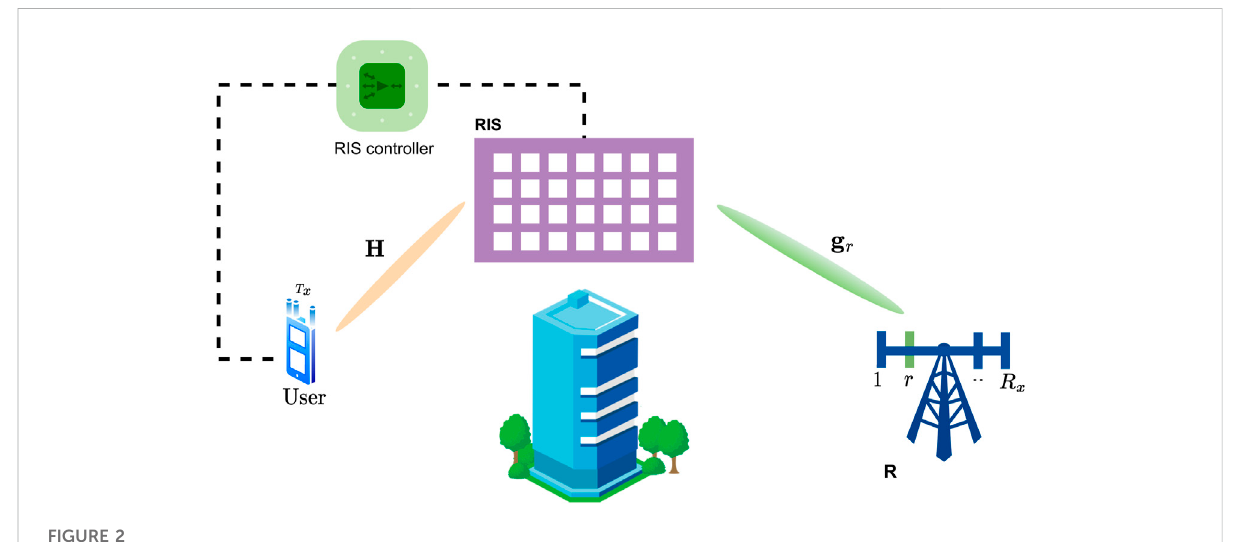
FIGURE 2 Over-the-air receive IM